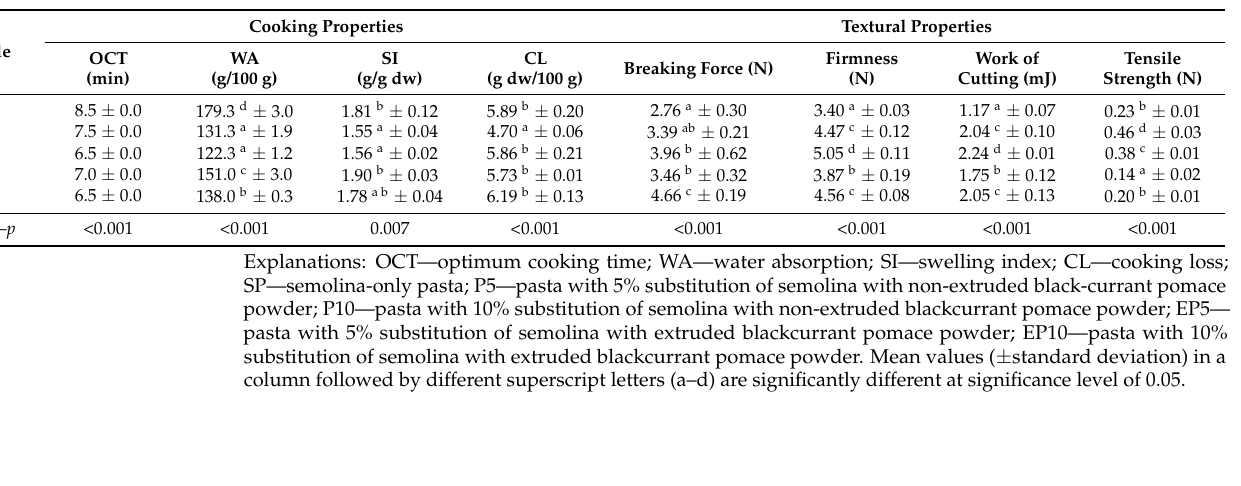
Table 2. Cooking and textural properties of pasta